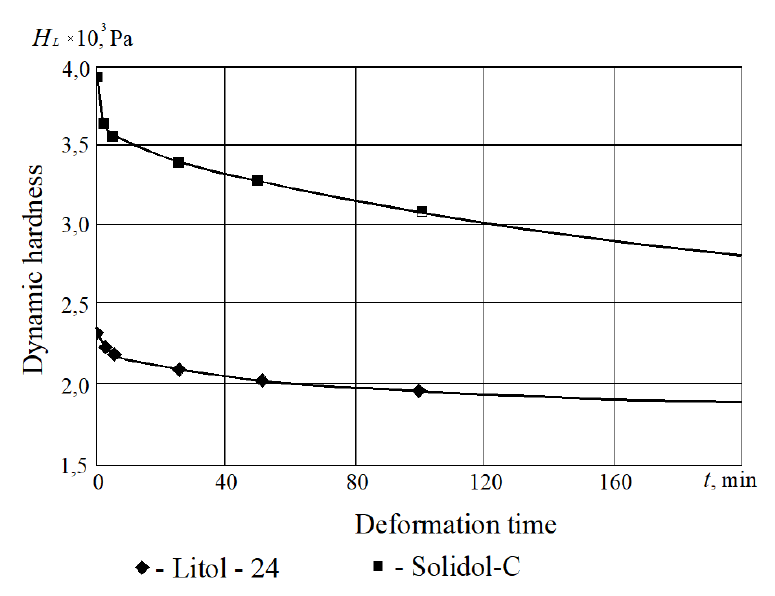
Fig. 4. Dynamic hardness of lubricants during